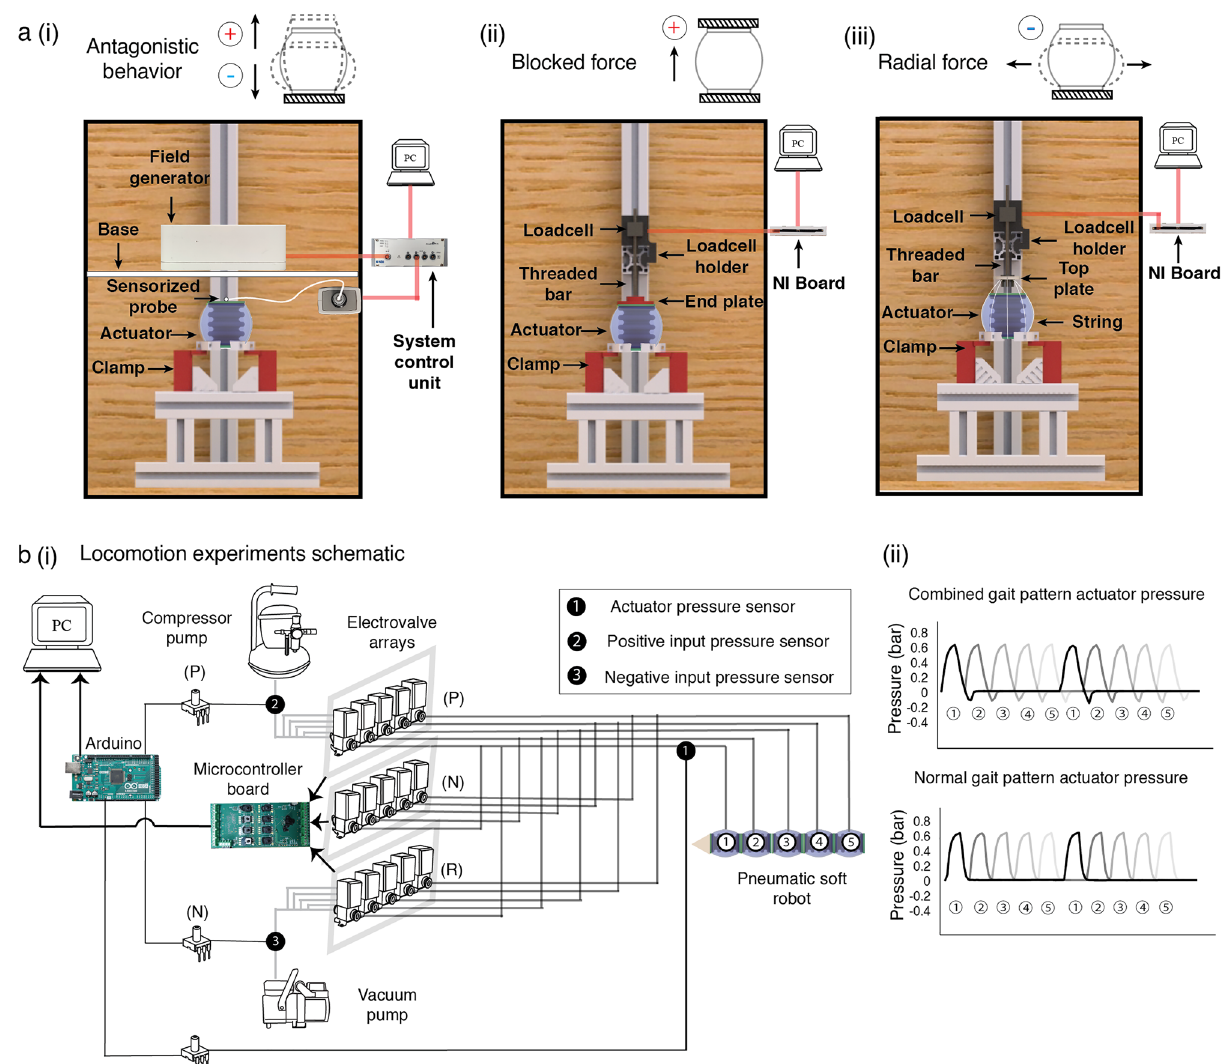
Figure 5. Actuator characterization and locomotion setup. ( a) (i) Aurora Electromagnetic tracer system (NDI) mounted on top of PSA to measure its deformation when actuated giving an estimate of the antagonistic behavior. (ii) Loadcell with an end plate restricting the longitudinal deformation of the PSA was used to measure its blocked force. (iii) End plate was replaced with a top plate containing 6 equidistant holes. 6 strings attached to the bottom of the actuator passed along the surface of the PSA to the top plate translating the radial force to tensile force for the loadcell. ( b) (i) Pneumatic setup to perform locomotion experiments containing electrovalve arrays to generate different gait patterns. Schematic (ii) variation of actuator pressure throughout the robot comparing EGP and CGP for two complete locomotion Locomotion. As shown in Fig. 1b, the PSA modules filled with gel were extended by 5 mm and slotted by 2 mm to allow the lightweight laser-cut connectors to be properly attached to mount five actuator modules in series (robot length = 350 mm). A pneumatic system (Fig. 5b(i)) with three arrays of five electrovalves was set up to perform the motion experiments and generate different gait patterns, as explained in Supplementary Fig. S5. Since the characterization of the PSA was performed at a pressure of 1 bar for elongation and 0.5 bar for compression of each module, the locomotion experiments were performed at an optimal pressure of 0.7 bar for elongation and at the same vacuum pressure of 0.5 bar to avoid damage and leakage of the modules. As shown in Fig. 5b(i), the electrovalve arrays were controlled by the microcontroller board to generate different gait patterns and move the robot in relation to the particular experiment being performed. For the experiments on flat surfaces, the robot was made to travel a fixed distance of 10 cm while varying two parameters: (i) the gait pattern (EGP and CGP), and ii) the surface friction (with setae and without setae). For locomotion in granular medium, the surface of the granules was first aligned horizontally, and the robot was put into location. A box (50 cm × 100 cm × 40 cm) filled with white granules served as the experimental setup in accordance with the desired height (20 mm or 40 mm), so that the marker was just above the surface of the medium and could be tracked. Visible markers were placed at 20 mm and 40 mm heights on the head of